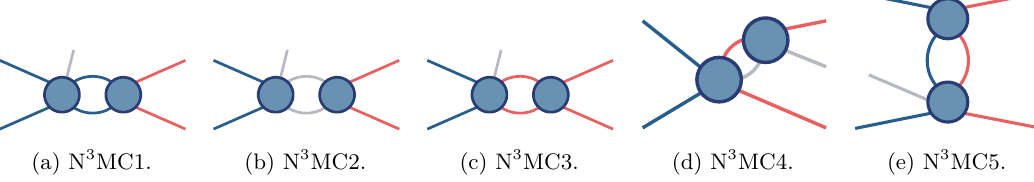
Figure 11 . N 3 -maximal bubble cuts of the one-loop five-point amplitude. Dark blue blobs represent four and five-point amplitudes, and exposed legs represent on-shell